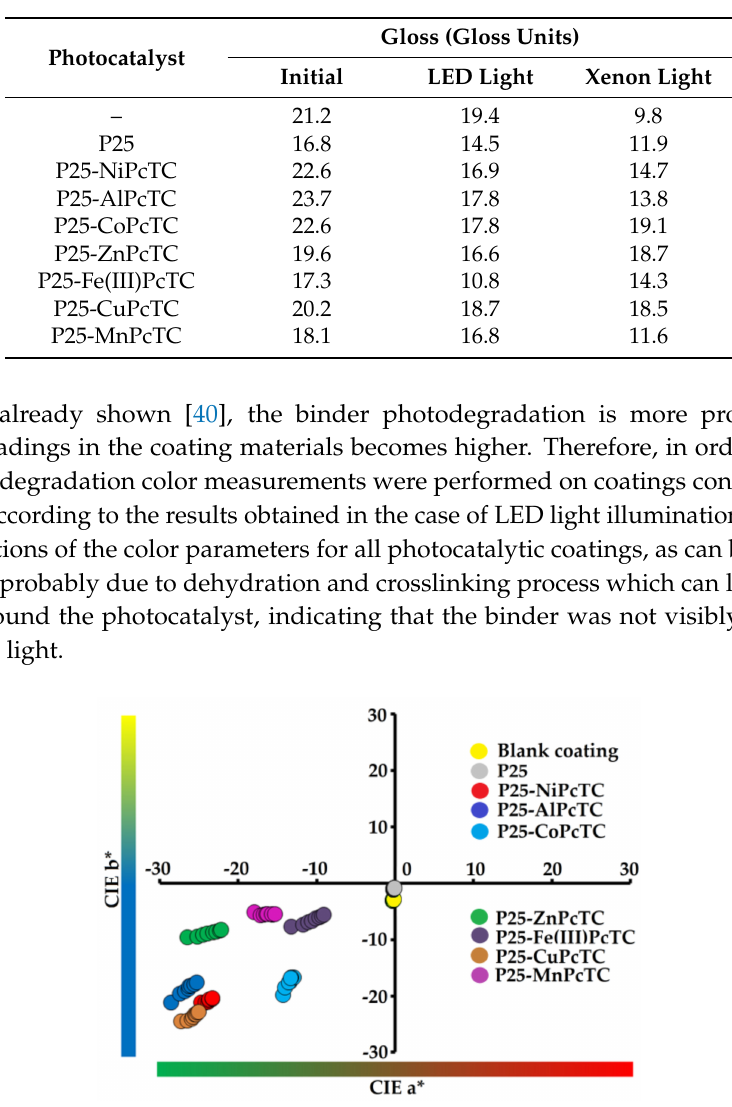
Figure 5. The evolution of CIE a * and b * color parameters of the photocatalytic coatings during exposure to LED